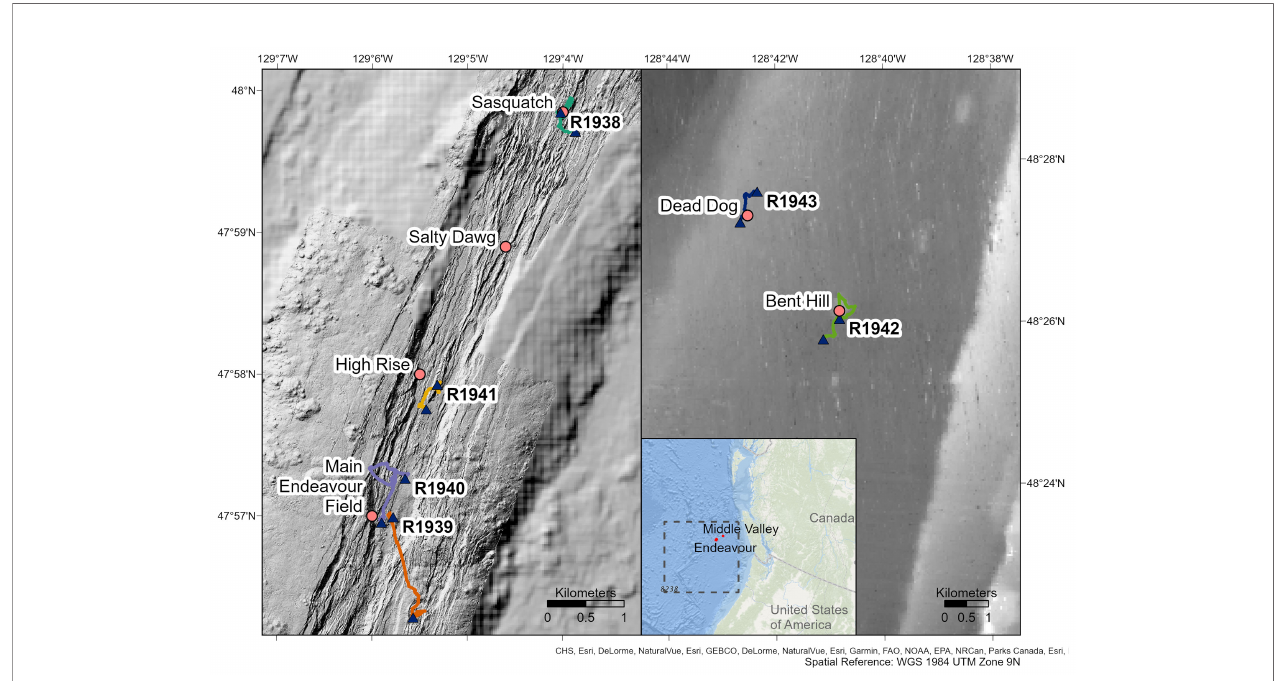
FIGURE 1 | Track lines of dives R1938-R1943 conducted by the remotely operated vehicle ROPOS on the Endeavour (left) and Middle Valley (right) segments of the Juan de Fuca Ridge. Triangles represent the start and end points of dives. Known vent fi elds are shown. The general location of the Juan de Fuca Ridge (dashed box) and position of Endeavour and Middle Valley are shown in the inset map. Maps created in ArcGIS Pro, bathymetry and vent locations provided by ONC, MBARI, and the University of